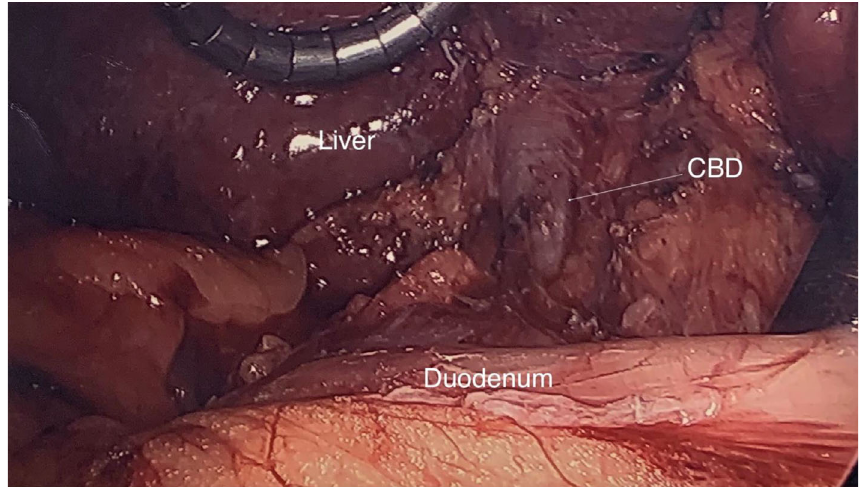
Figure 2: 35-Year-old female with biliary colic concerning for acute cholecystitis. Findings: intraoperative photograph showing common bile duct (CBD arrowed), the liver, and the duodenum with the absence of a